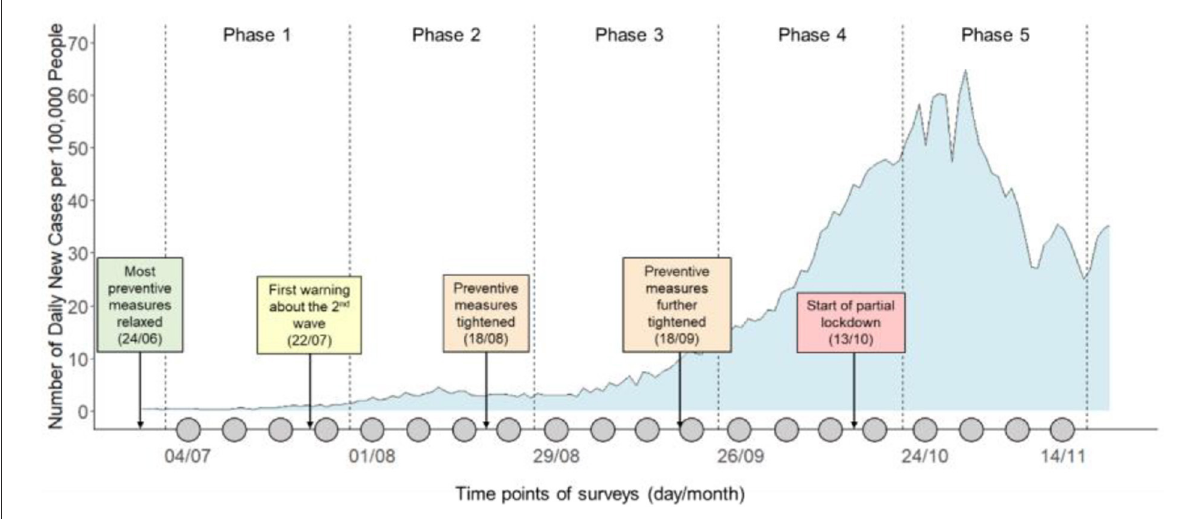
FIGURE1 Timeline of the monitoring period in the context of the development of COVID19 pandemic in the Netherlands. Each gray dot on the timeline represents a weekly survey. The curve in the background indicates the number of daily new detected cases per 100,000 people.